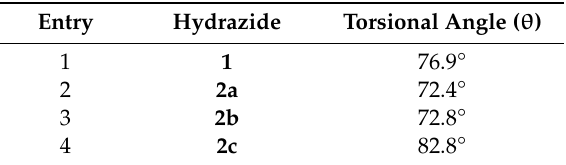
Table 1. Torsional angle ( θ ) (CO– N – N –CO) of the evaluated hydrazides a . Entry